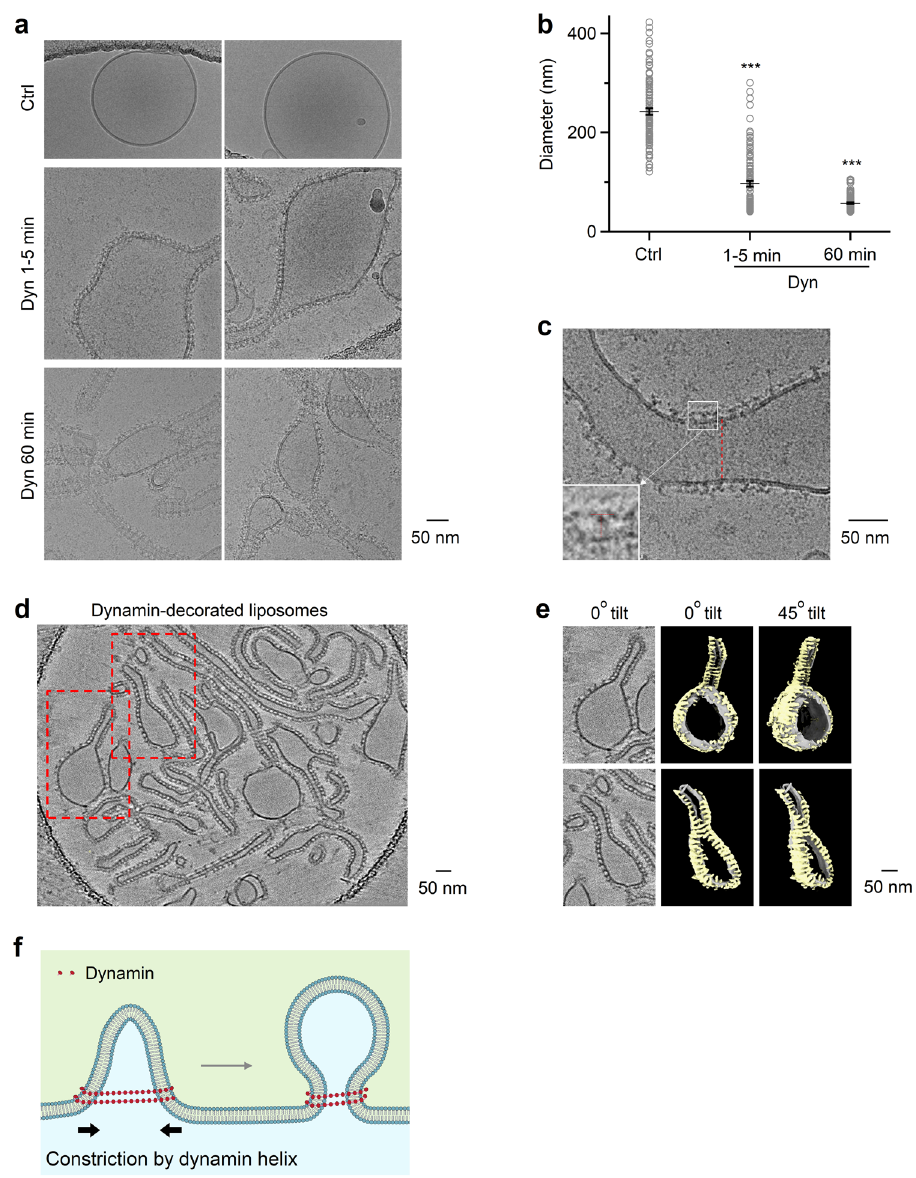
Fig. 5 Dynamin helix reduces liposome size in vitro. a , b Sampled cryoEM images ( a ) and diameter ( b ) mean ± SEM) of DOPS vesicles coated without (Ctrl, n = 104) or with dynamin 1 after dynamin 1 incubation for 1-5 min (Dyn 1-5 min, n = 104, p = 6.75 × 10 − 39 ) or 60 min (Dyn 60 min, n = 104, p = 5.82*10 − 70 ). *** p < 0.001, two-tailed unpaired t -test (compared to Ctrl); each circle represents a liposome (104 micrographs from 3 independent experiments). c Dynamin 1 assembled around large liposomes. The regular pattern of dynamin as ‘ T ’ structures on the edge of the lipid bilayer (insert) and the striation pattern seen on the lipid (dotted red line) suggests dynamin is wrapping around the lipid as a helix. d Cryo-electron tomogram of dynamin 1 with DOPS vesicles. Several dynamin-decorated vesicles and tubes are apparent with the characteristic T-shaped structure of dynamin extending from the membrane. Red-dashed boxes indicated two regions of the tomogram that were segmented as shown in panel ( e ). e CryoET segmentation of two DOPS vesicles with diameters of ~166 nm (top) and ~85 nm (bottom). Left panels, central slice of tomograms with dynamin T-shaped structures around vesicles and tubes. Middle and right panels show 3D segmentation of vesicles at 0°C and ~45°C tilts respectively. As you rotate the segmented volumes, striations of the dynamin density (yellow) are observed indicating a helical assembly of dynamin around the lipid bilayer (grey). f Schematic drawing: dynamin helix surrounds and constricts Λ ’ s base, converting Λ to Ω . This drawing is similar to Fig. 4g, except that the label “ Base constriction ” is changed to “ Constriction by dynamin helix ” , according to results shown in Fig. 5 a – e . Source data are provided as a Source Data fi